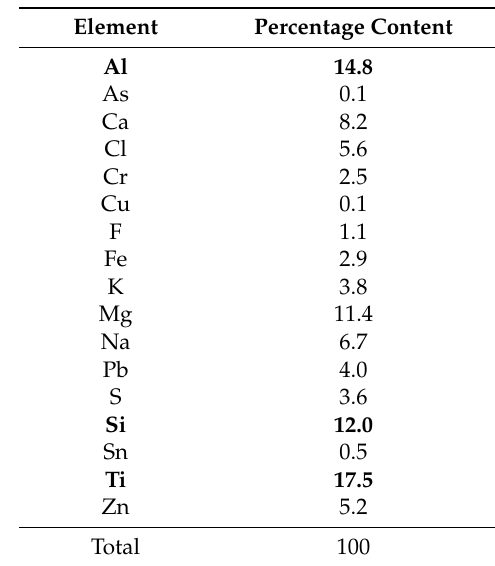
Table 1. Averaged Elemental Composition of the Aerosol Particles Collected on Filters from the Workspace Air of Aluminum-Titanium Alloy Production Facilities (expressed in % of Total Elements Less Carbon and